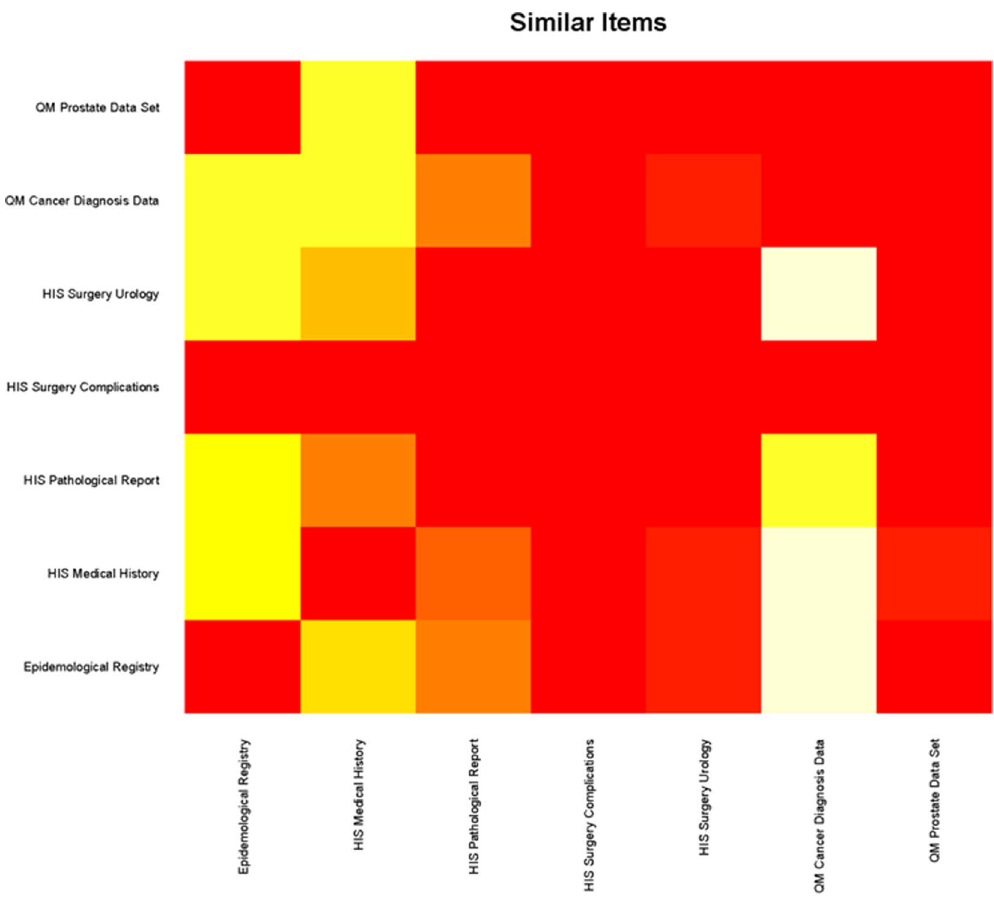
Figure 4. Grid-Image example based on the matrix with comparison results of similar items. This figure shows the absolute number of similar items in a pairwise comparison. Yellow cells represent high number of similar items; red cells represent zero similar items between the two respective forms.